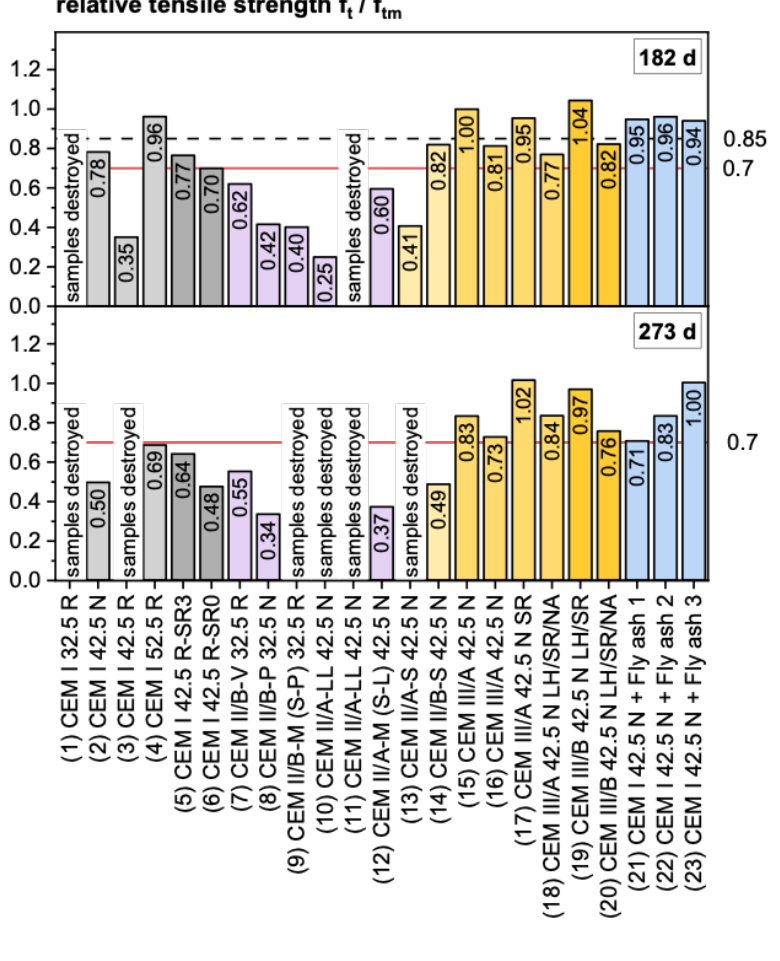
Figure 6. Relative tensile strength f t /f tm of concrete with 23 di ff erent binders after 182 and 273 days.